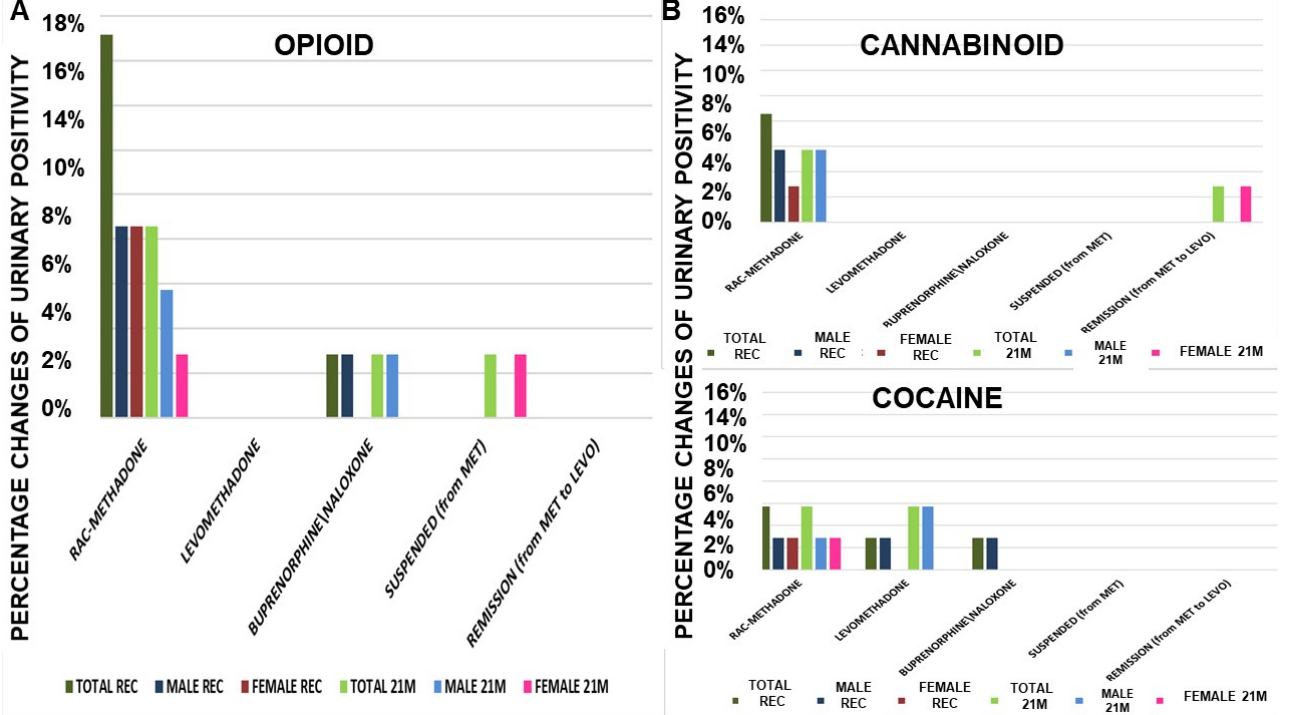
Figure 2. Opioids urine positivity at recruitment (REC) and after 21 months (21M) of therapy ( A ). Levomethadone was fully effective in preventing the cannabinoids positivity, but not rac-methadone and buprenorphine/naloxone. ( B ) Cannabinoids urine positivity at recruitment (REC) and after 21 months (21M) of therapy. Levomethadone and buprenorphine/naloxone were fully effective in preventing the cannabinoids positivity, but not rac-methadone. Cocaine urine positivity at recruitment (REC) and after 21 months (21M) of therapy. The treatments were less effective in preventing cocaine positivity. MET = rac-methadone, LEVO = levomethadone.